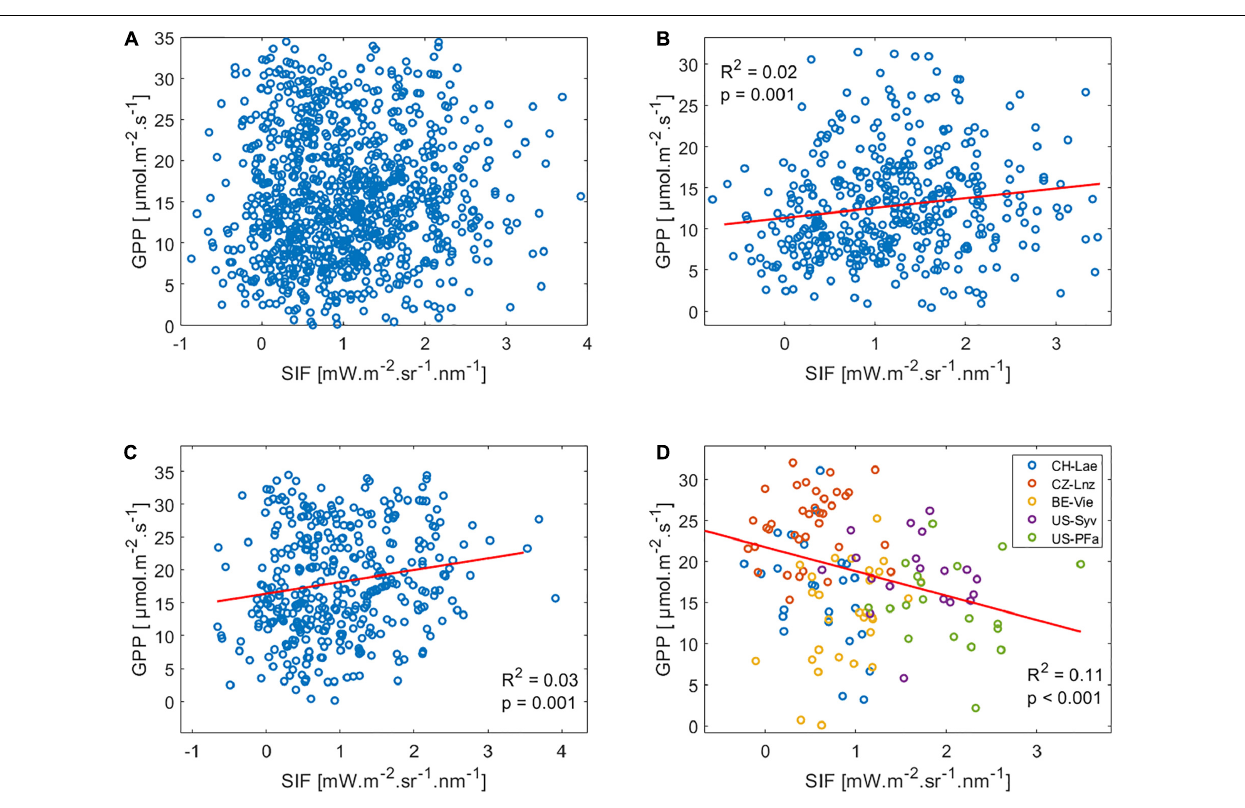
FIGURE 3 | GPP:SIF correlation for half-hourly data for (A) all 31 sites plotted together, (B) ENF sites, (C) DBF sites, and (D) MF sites. Red line represents the linear regression fit. A regression line is not shown where the regression is not